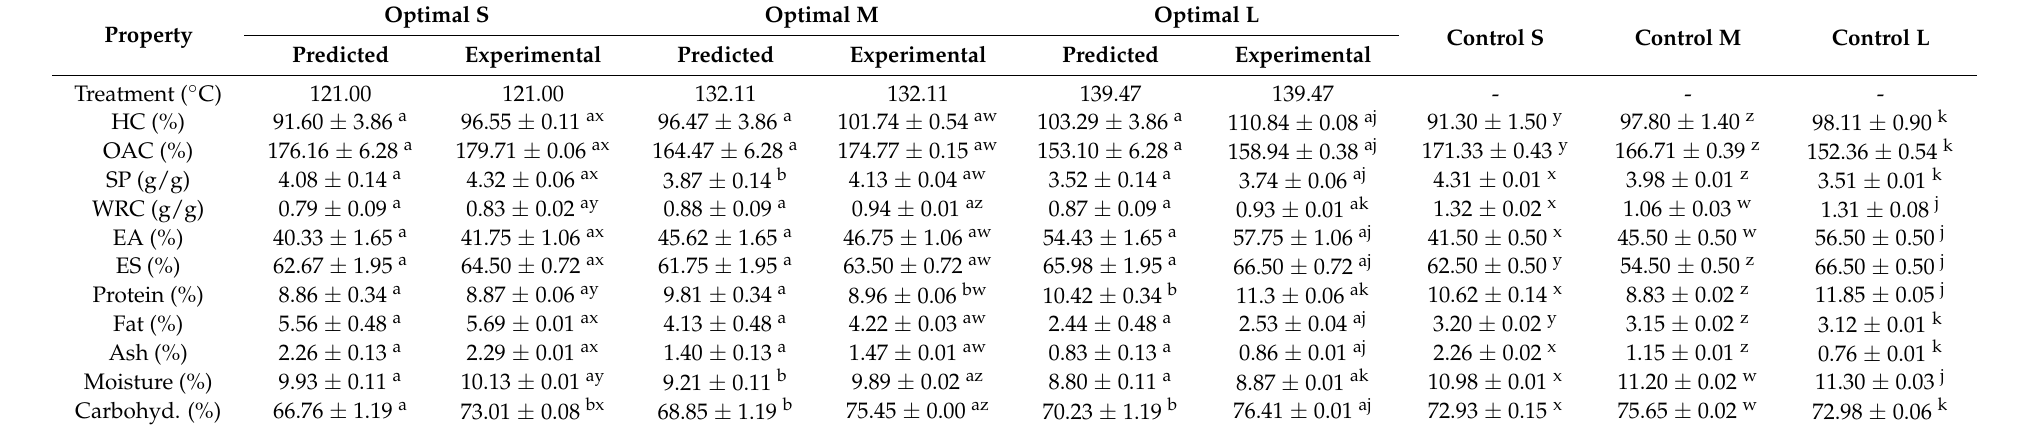
Table 5. Model validation. Properties of the optimal samples compared to the control